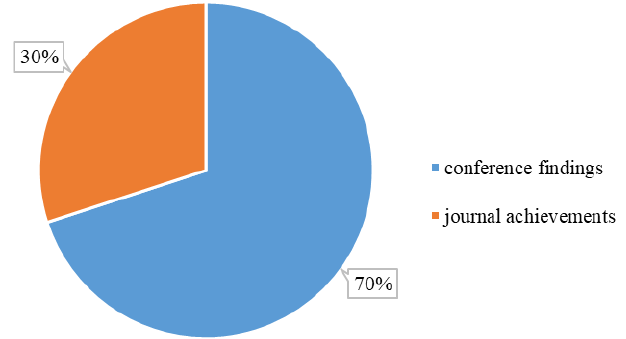
Figure 3. The distribution by study type in the Included Study . The “conference findings” and “journal achievements” refer to the studies published in the conferences and journals, respectively.